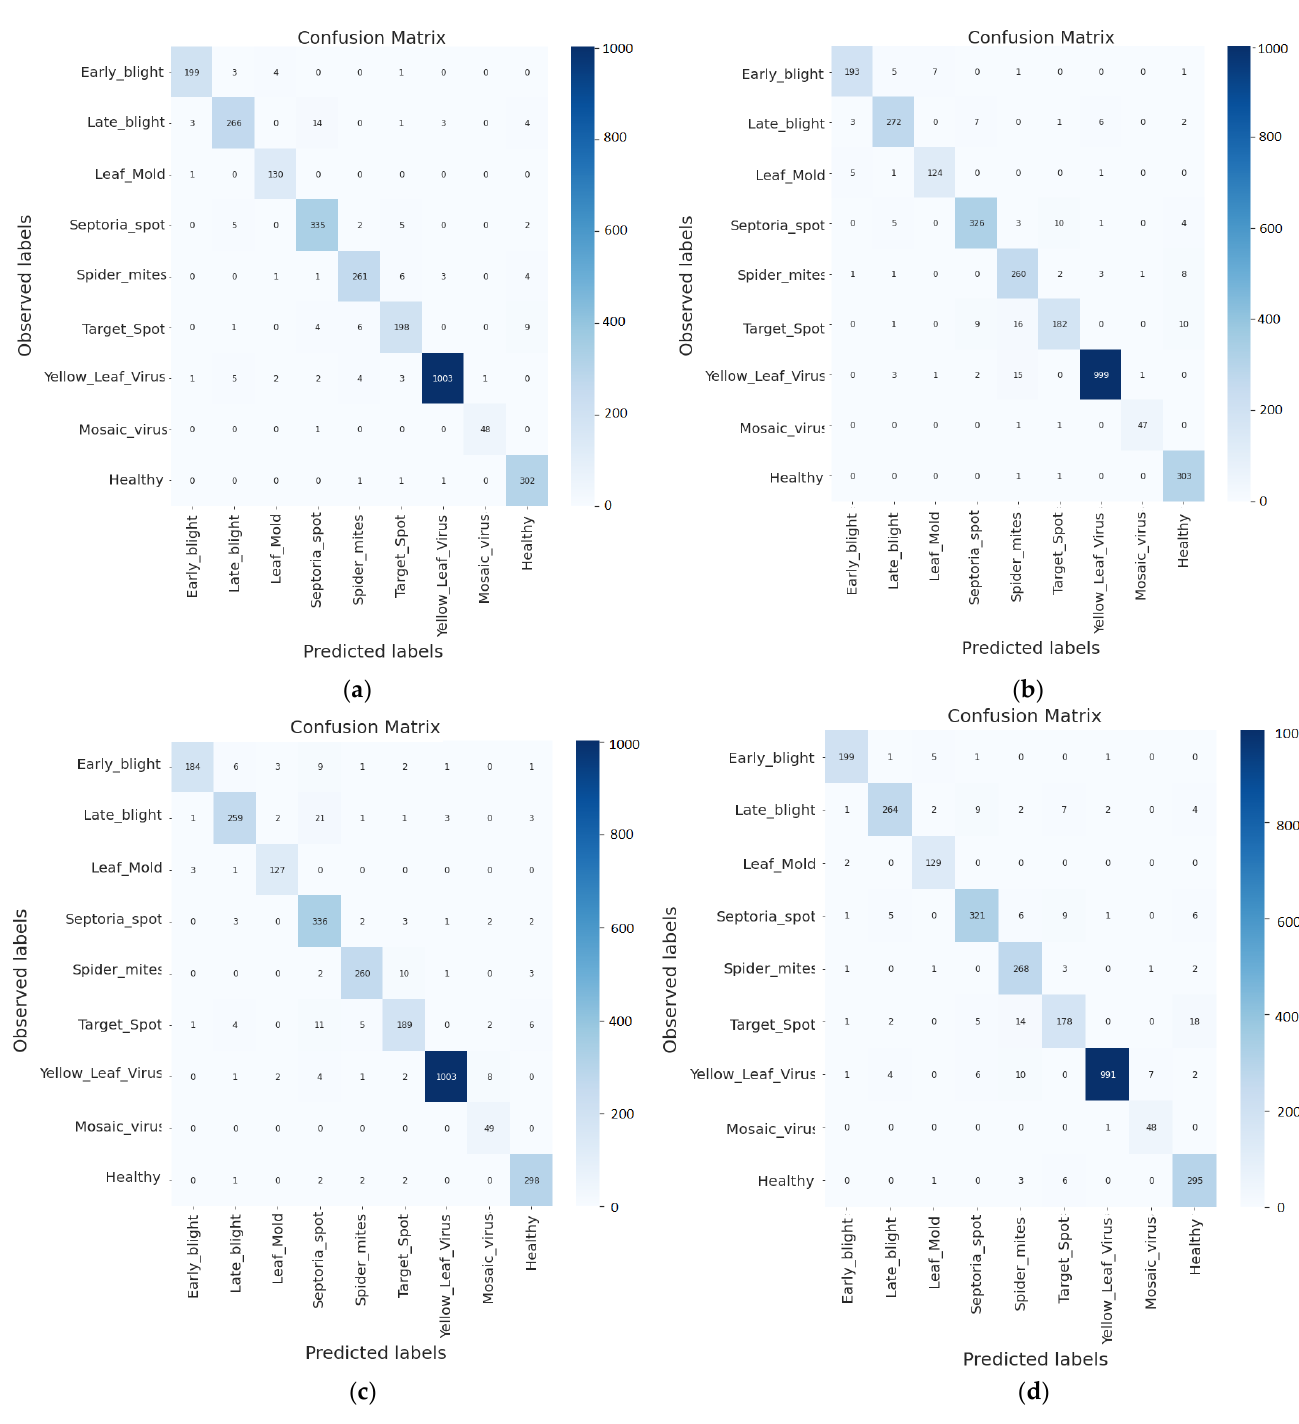
Figure 15. Confusion matrix results of the four best-performing models: ( a ) MobileNet, ( b ) SqueezeNet, ( c ) NasNetMobile, and ( d ) MobileNetV2. Numbers in the matrix mean the samples classified in each class, and the colors help to identify where more samples are classified (darker colors).